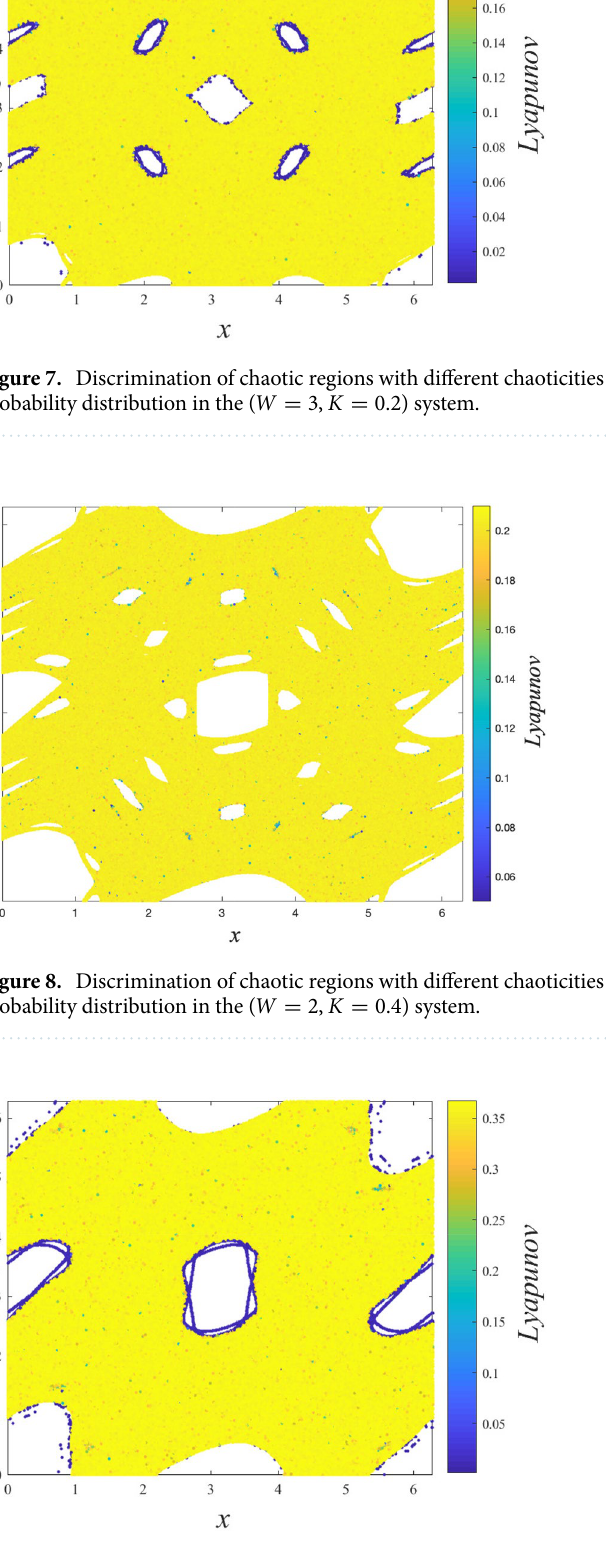
Figure 9. Discrimination of chaotic regions with different chaoticities that contribute two Gaussians to the probability distribution in the ( W = 2 , K = 0.6 )